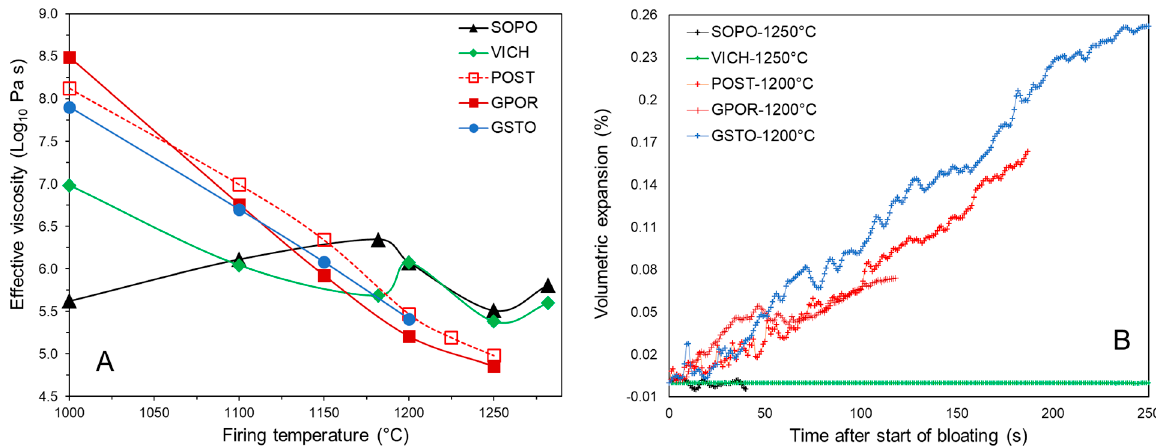
Figure 16. Effective viscosity vs. firing T °C ( A ) and bloating degree ( B ).